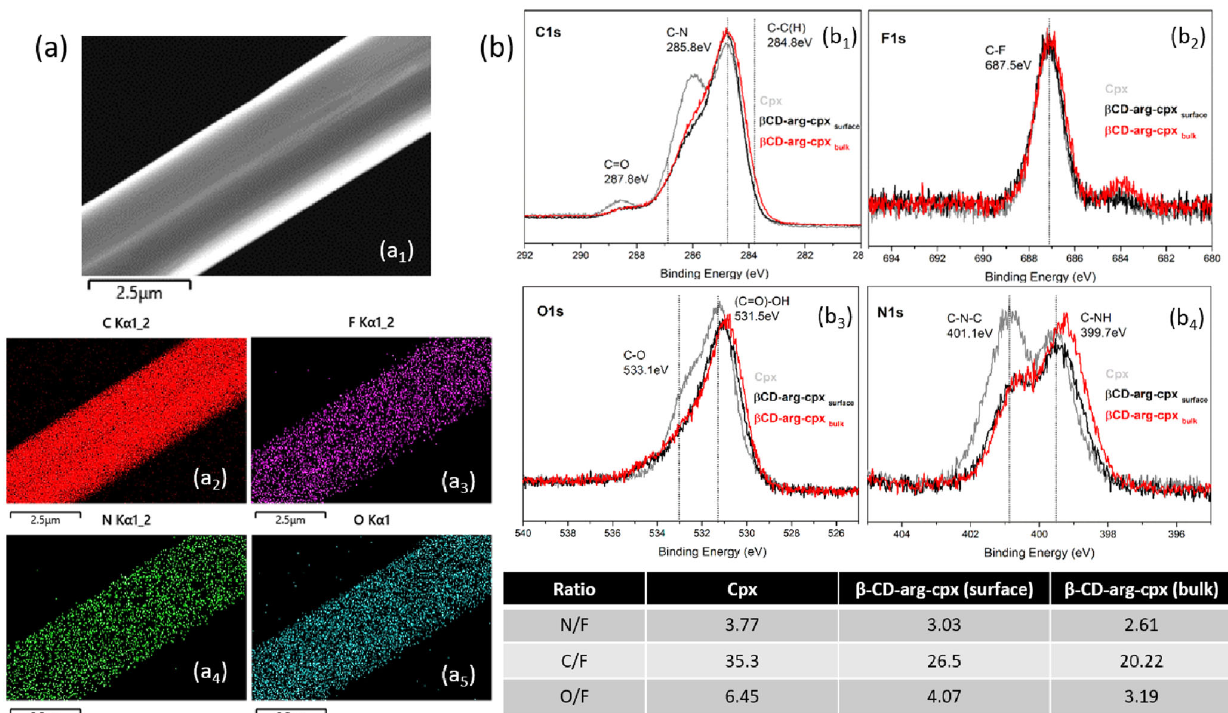
Fig. 2 Chemistry of the β CD-arg-cpx stable complex structure. STEM image (a 1 ) with elemental mapping analysis corresponding to carbon (C) (a 2 ), oxygen (O) (a 3 ), nitrogen (N) (a 4 ) and fl uorine (F) (a 5 ); XPS analysis of the surface and bulk (obtained after soft etching) of the β CD-arg-cpx complex in comparison to pristine cpx reference- C1s (b 1 ), F1s (b 2 ), O1s (b 3 ) and N1s (b 4 ) high resolution